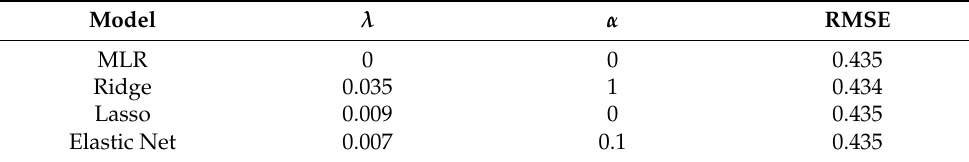
Table 4. Estimates of regularization parameters.